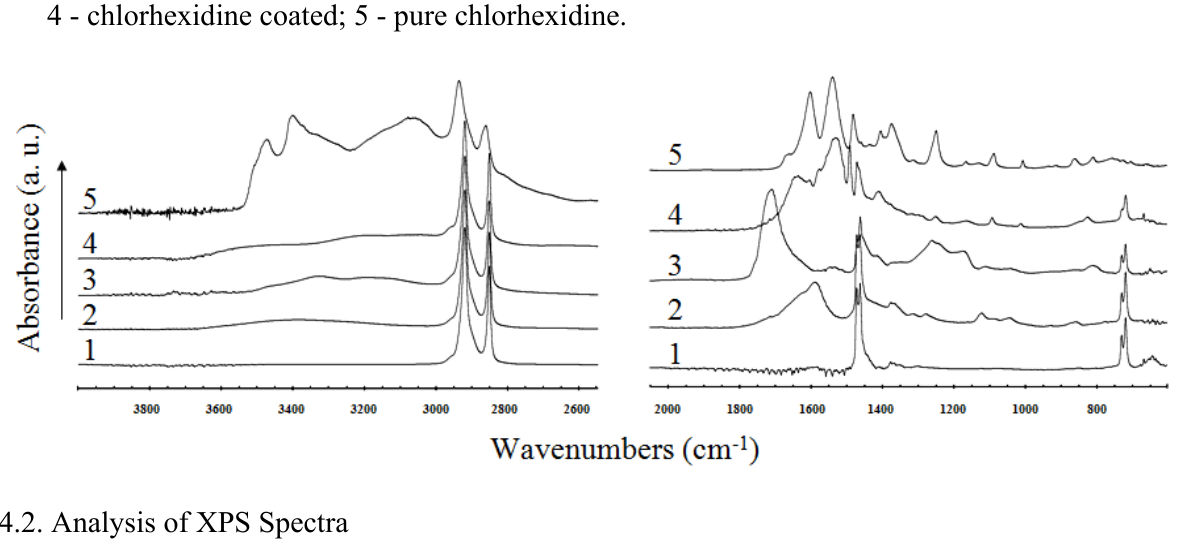
Figure 6. FT-IR-ATR spectra of: 1 - untreated LDPE; 2 - plasma treated; 3 - AA grafted; 4 - chlorhexidine coated; 5 - pure